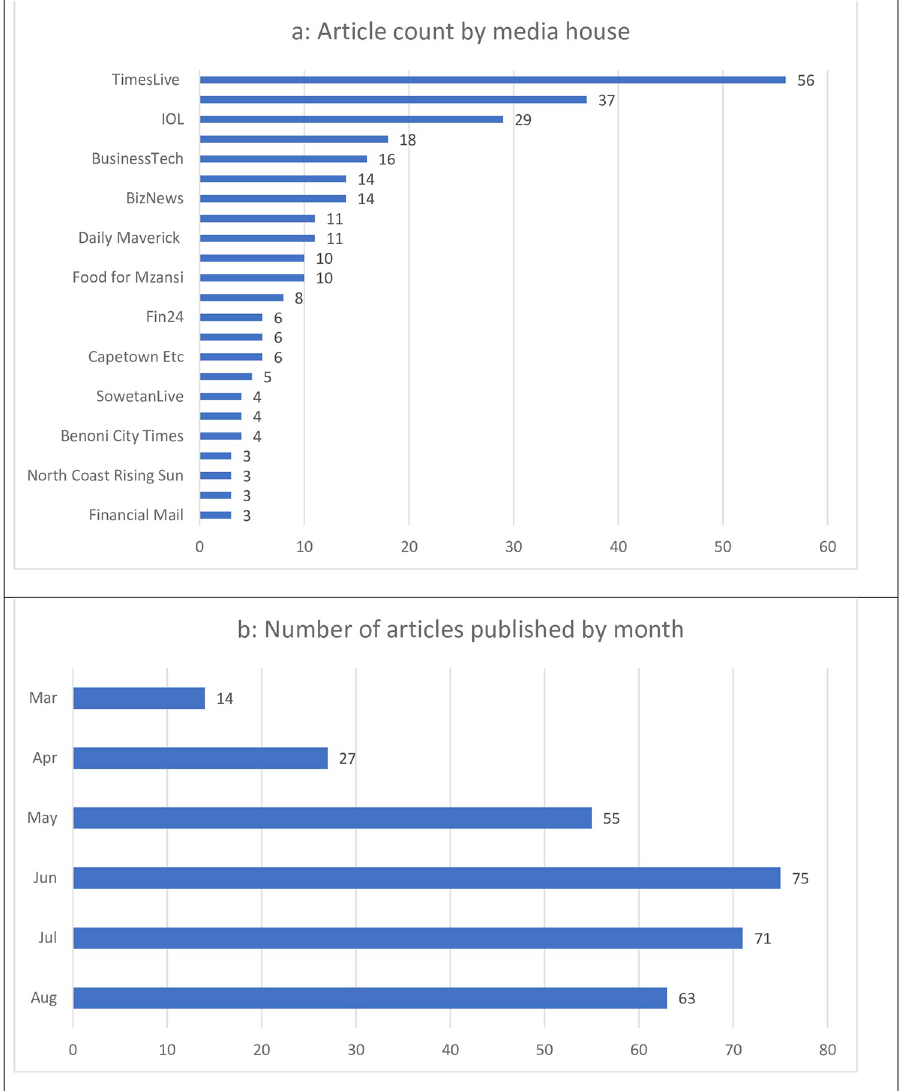
Fig 3. Distribution of news media publications by month of publication and media house. a. Publication count by media house; only newspapers with more than two published articles are included in this graph, b. Publication count by month during the period of the tobacco sales